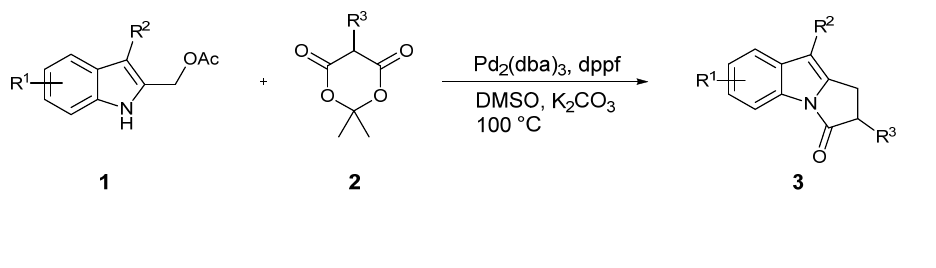
Table 2. Synthesis of 2-substituted 1,2-dihydro-3 H -pyrrolo[1,2- a ]indol-3-one 3 from indol-2-ylmethyl acetates 1 and Meldrum’s acid derivatives 2. a